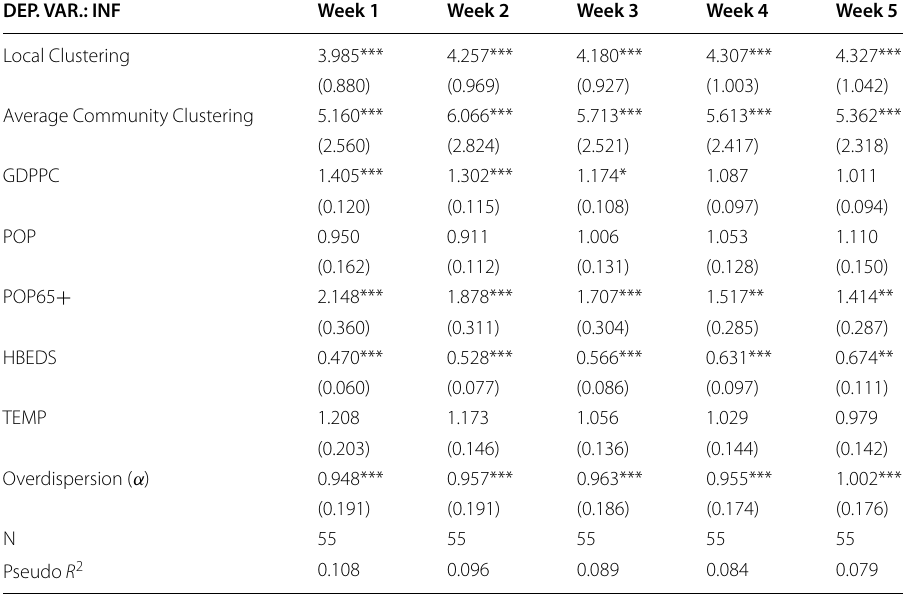
Country‑level clustered standard errors in